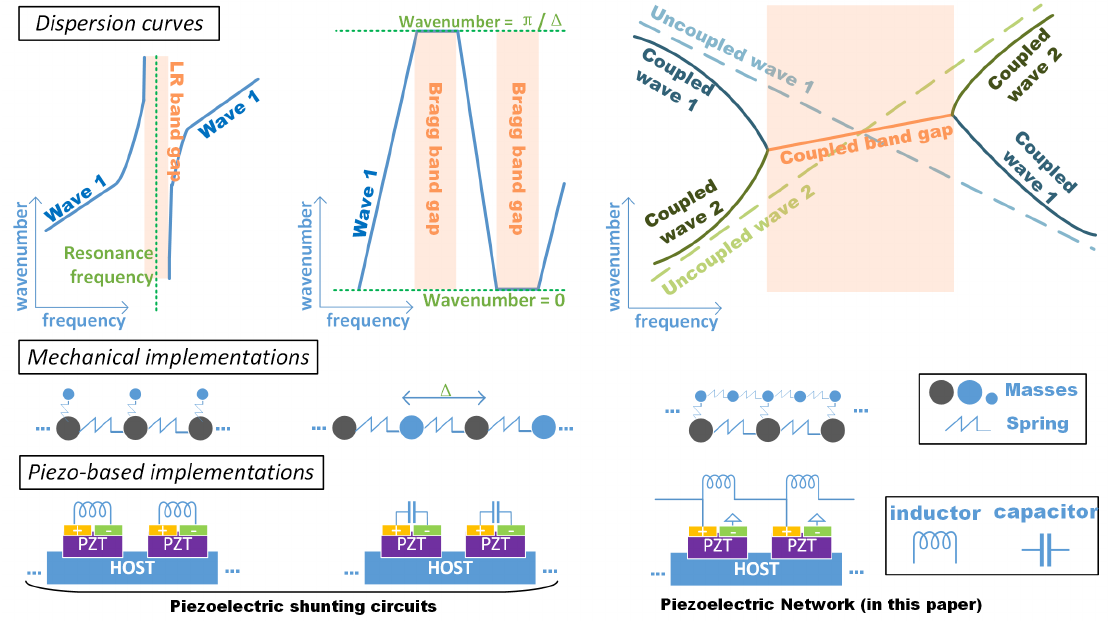
Figure 1. Schematic illustration of the main features for the dispersion curves, the mechanical and piezoelectric-based implementations for the Bragg, LR and coupled band